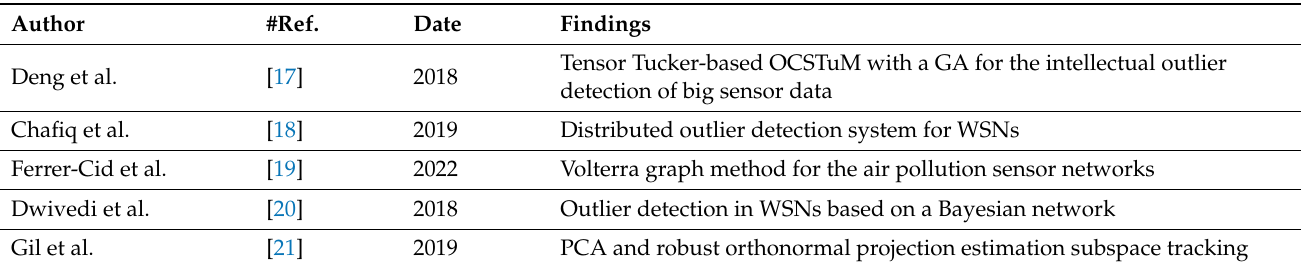
Table 1. A brief explanation of the